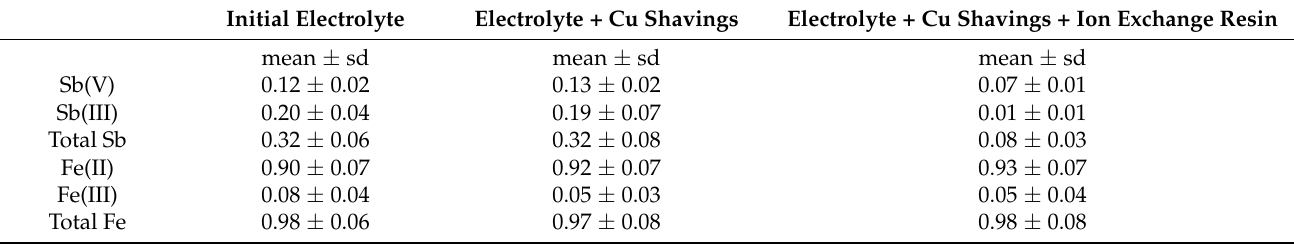
Table 1. Average concentrations (g L − 1 ) of Sb and Fe species in samples of initial electrolyte, treated electrolyte with Cu shavings and treated electrolyte with Cu shavings and ion exchange resin in the laboratory-scale plant. The results of the concentrations are expressed as mean ± standard deviation ( n =